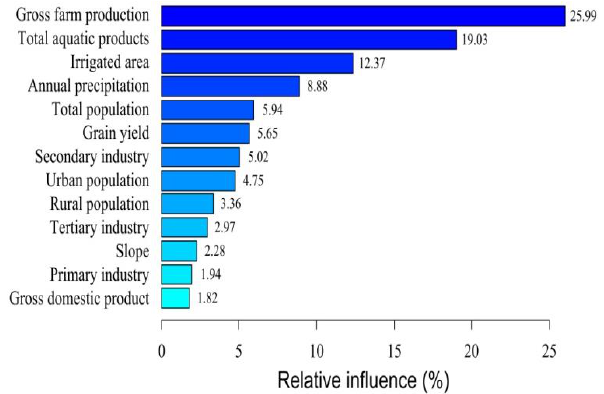
Figure 6. Relative influence of socioeconomic and natural factors on the decrease of natural wetland area.